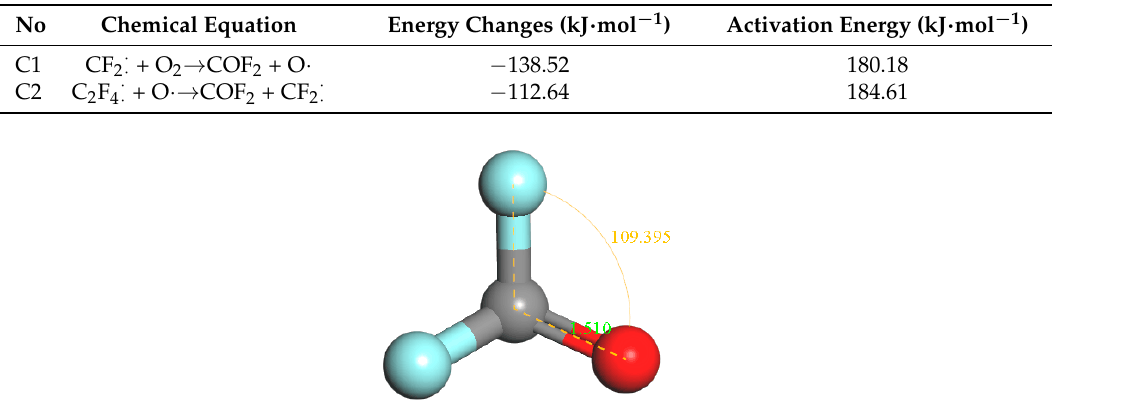
Table 5. Reaction path and energy change.